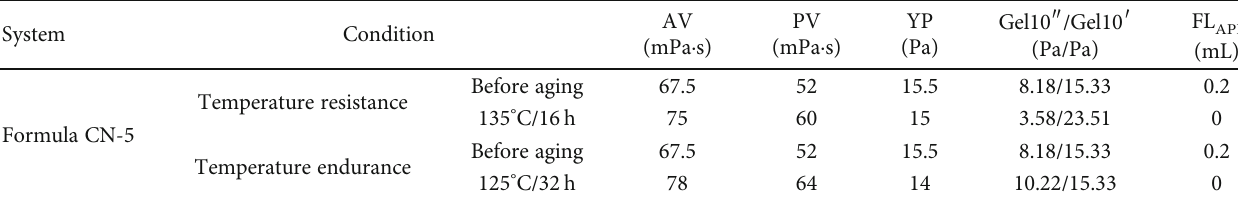
Table 9: Temperature resistance evaluation results of strong plugging drilling fl uid.